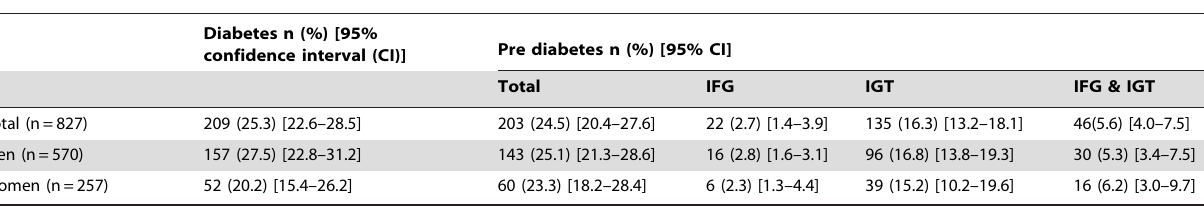
Table 2. Prevalence of diabetes and pre diabetes in South Indian TB patients.